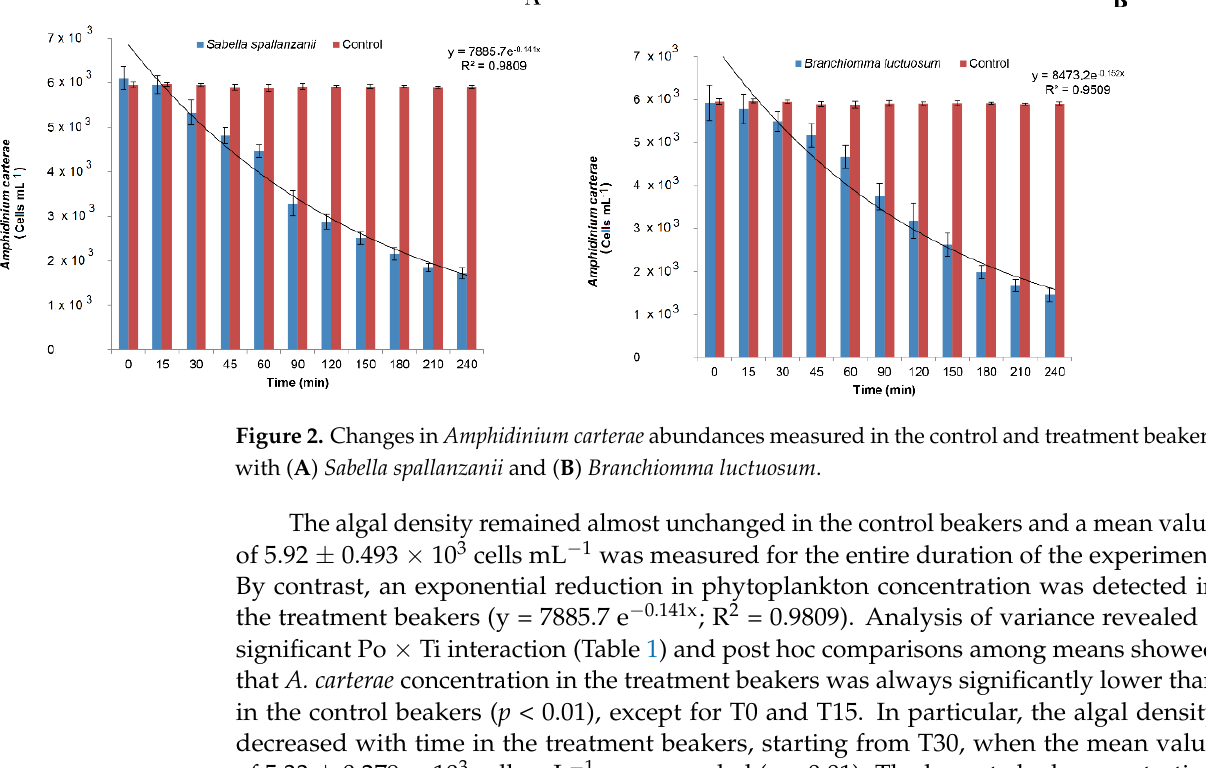
value of 5.92 ± 0.493 × 10 3 cells mL −1 was measured for the entire duration of the experi-